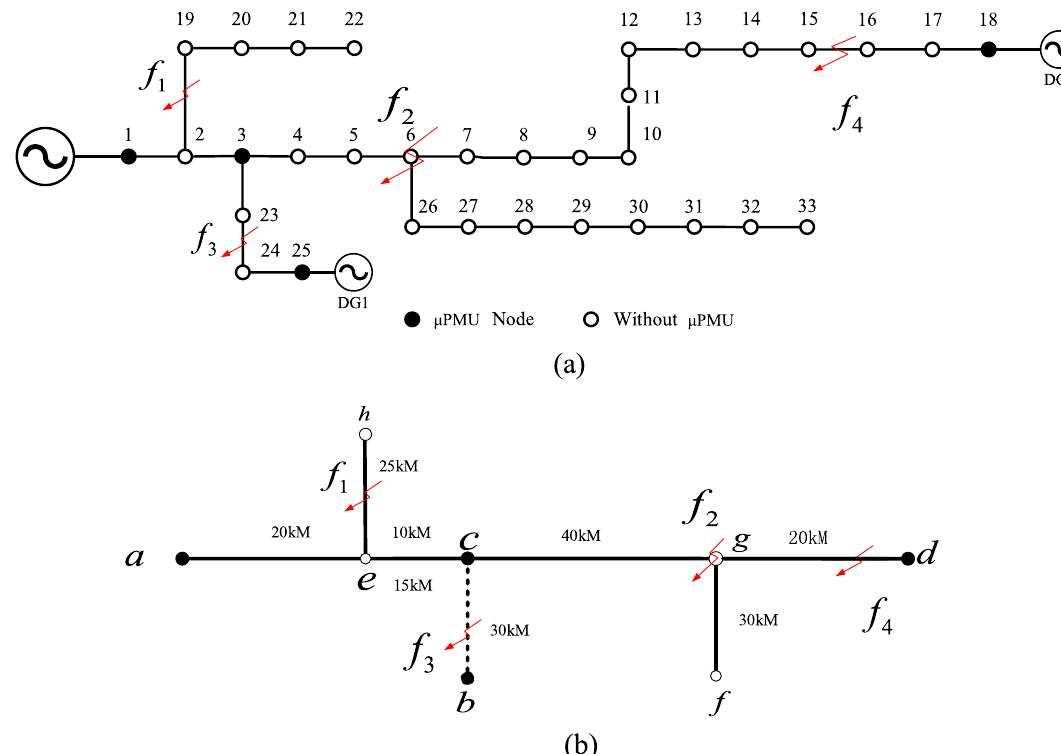
Fig. 6 The 10 kV overhead line-cable hybrid structure of distribution network topology: a standard IEEE 33 node 10 kV distribution network; b simplified diagram of simulation